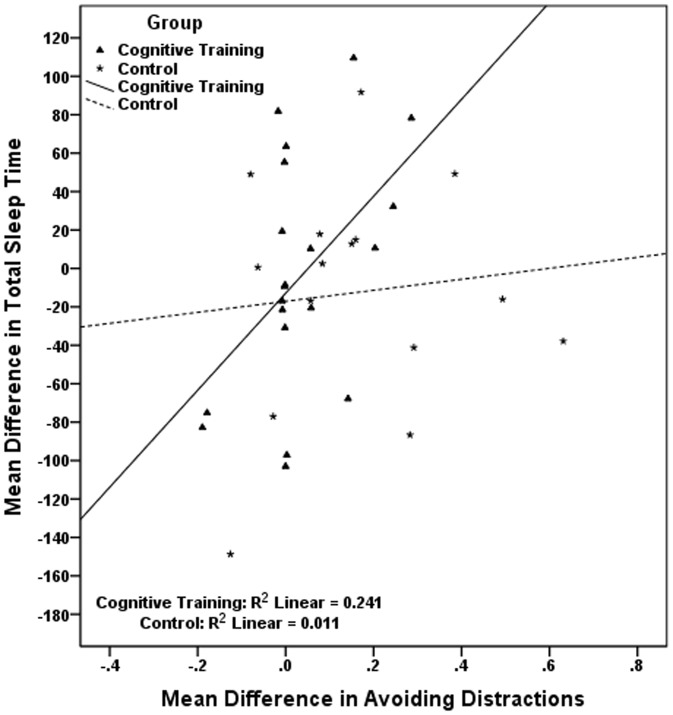
Linear regression between Mean Difference (post-intervention mean minus baseline mean) in Total Sleep Time (dependent) and Mean Difference (post-intervention mean minus baseline mean) in Avoiding Distractions (independent).